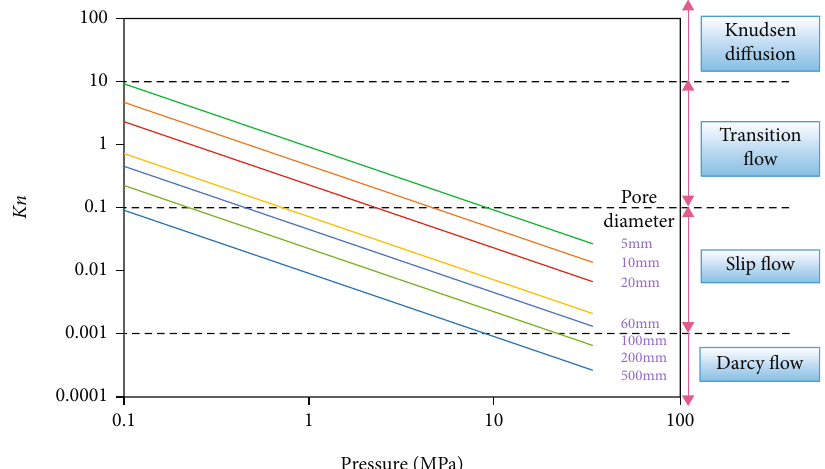
Figure 3: K changing with pressure and pore diameter for CO n